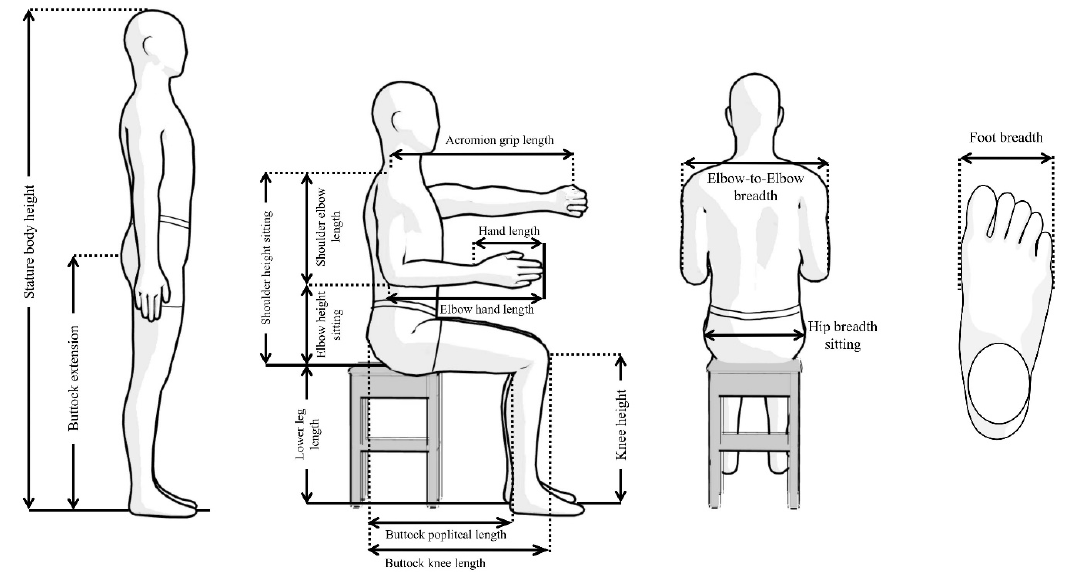
Figure 3. Anthropometric measurements.